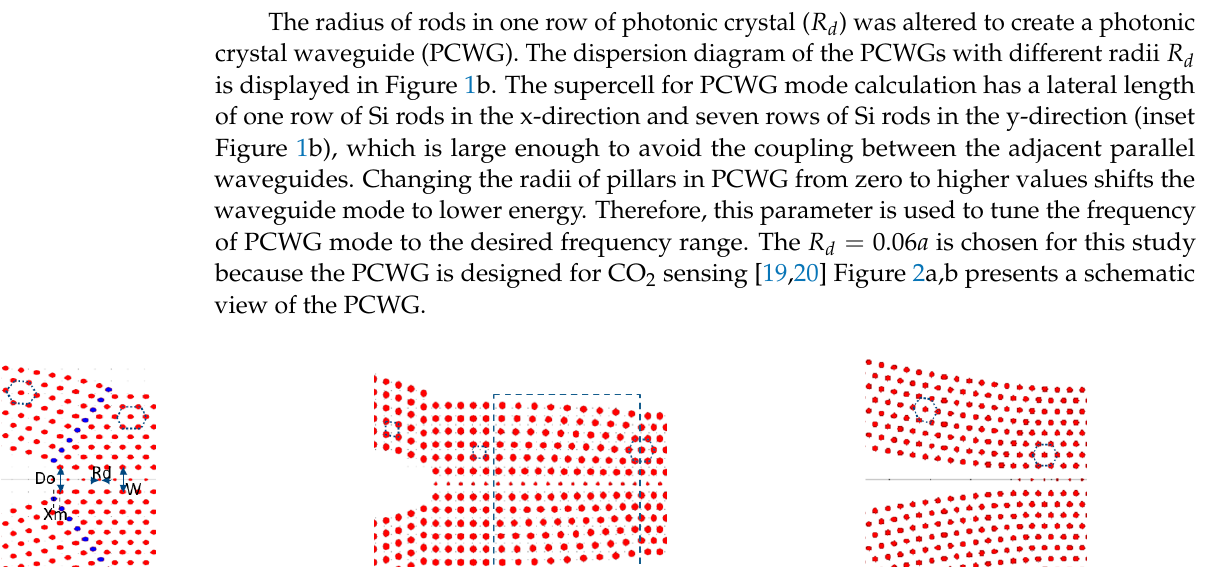
Figure 1. ( a ) TE dispersion band diagrams of a PhC of silicon rods in a hexagonal lattice with 𝑟 = 0.2𝑎 . The shaded area presents the photonic bandgap and the dash-dotted black line shows the light line. Modes below the light line are vertically confined into the PhC, ( b ) dispersion diagram of the PCWG modes with different radii inside the bandgap, in which the periodic supercell for simulation is shown in the inset.